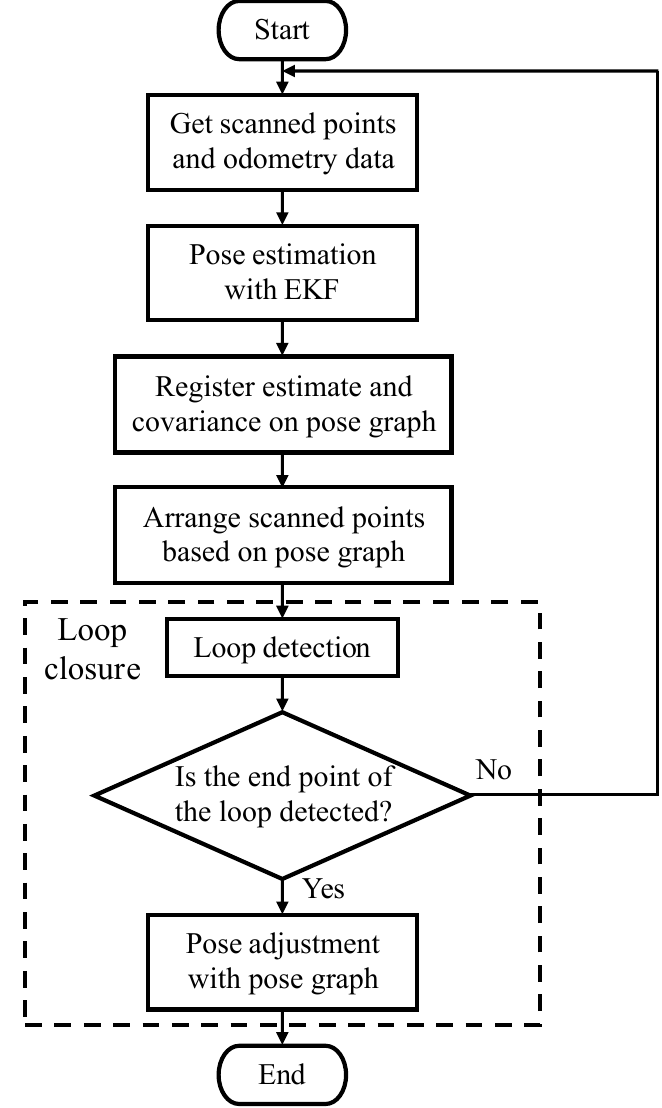
Figure 6. Flowchart of the window shape estimation. In the estimation, the robot’s pose is estimated by the EKF with odometry data, and the estimate and the covariance of the robot’s pose are registered on the pose graph of the robot. Based on the pose graph, the positions of the points obtained by the 2D scanner are recorded. In the loop closure, the end point of the loop of the robot’s trajectory is detected, and the pose adjustment is carried